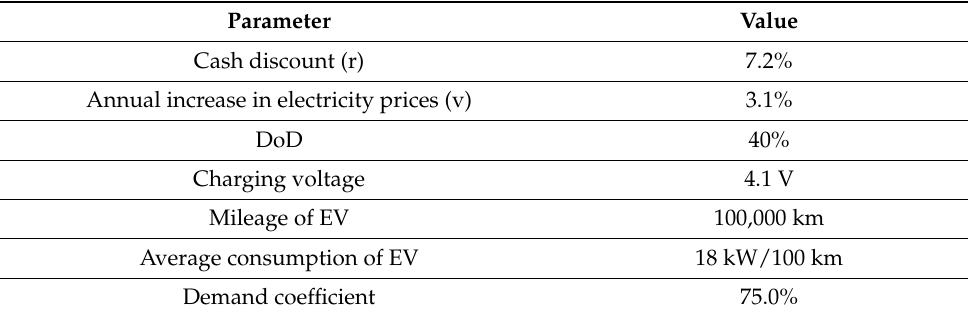
Table 5. Input parameters for calculating the 2nd life battery.